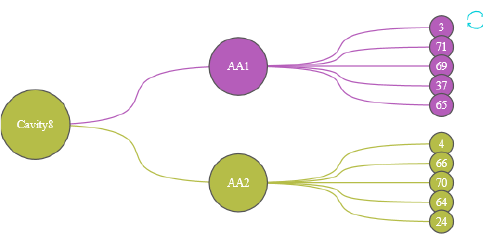
Figure 8. The first layer represents the cavity number, the second layer represents the cavity-lining amino acids that affect the cavity, and the third layer of amino acids affects the cavity dynamics by affecting the amino acids in the second layer. The colors of the nodes are inherited from the AAFS Clustering View.